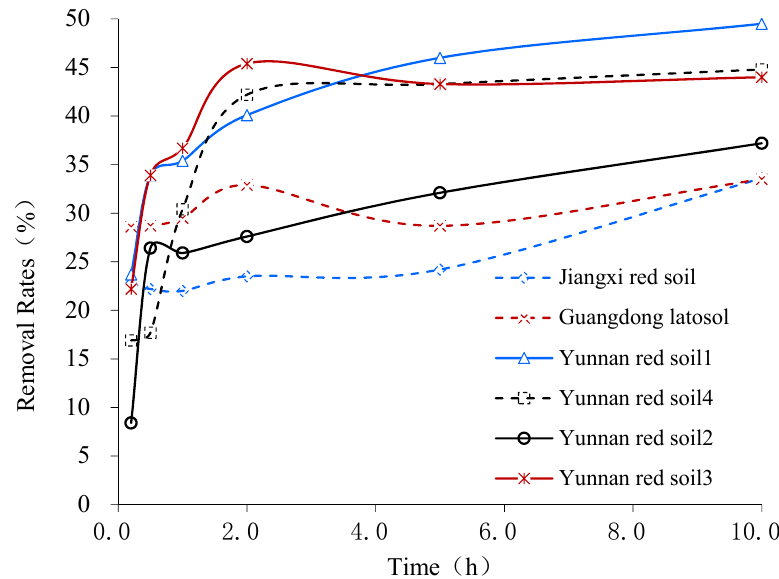
Figure 1. Removal Percentage of As( Ⅴ ) on Different Red Soils.